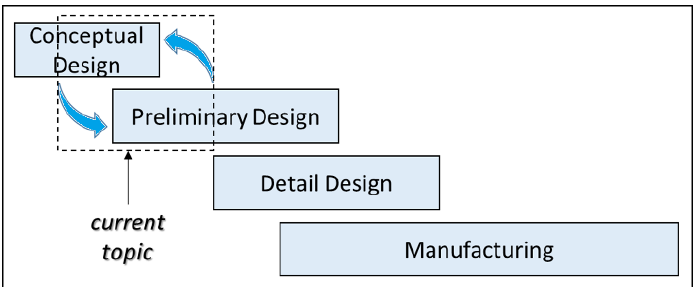
Figure 5. Generic timeline of a design process.